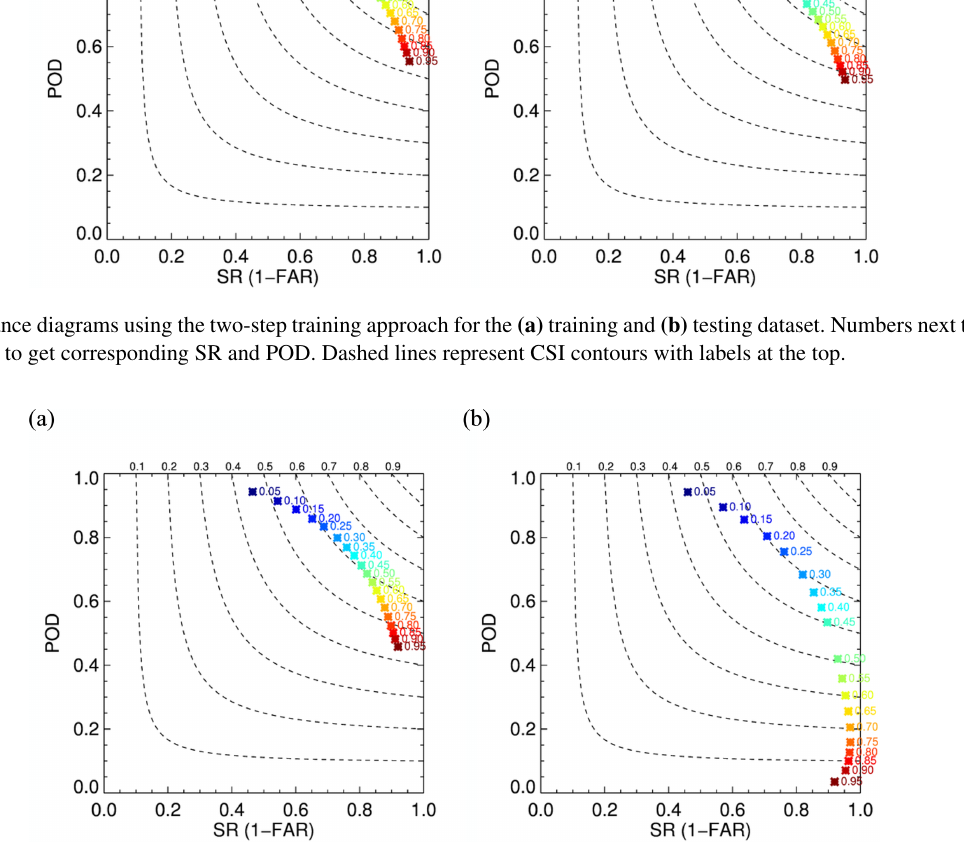
Figure 3. Performance diagrams using a model trained with the (a) two-step training approach and (b) standard approach the for testing dataset. Numbers next to the symbol are thresholds used to get corresponding SR and POD. Dashed lines represent CSI contours with labels at the top. The maximum CSI value is (a) 0.62 and (b) 0.61. CSI above 0.6 is achieved in panel (a) for thresholds from 0.25 to 0.45 and in panel (b) only for thresholds from 0.2 to 0.25. POD, FAR, SR, and CSI for all thresholds shown here are provided in Tables A2 and